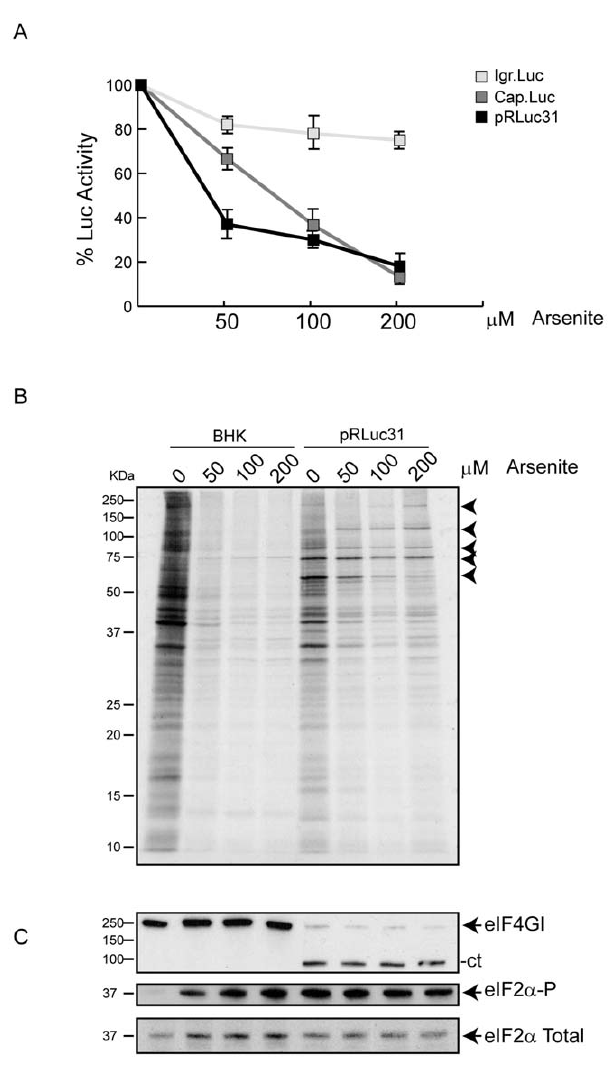
Figure 1. Effect of eIF2 phosphorylation induced by Ars on PV protein synthesis. A) Cap-luc, PV replicon-luc or CrPV IGR-luc mRNAs synthesized in vitro by T7 RNA polymerase were electroporated in BHK- 21 cells and seeded in DMEM (10% FCS). Different amounts of Ars (0, 50, 100 and 200 m M) were added and cells were incubated for 60 min before harvesting to analyze luc. Error bars indicate standard deviations (SD) obtained from three measurements of each sample. B) BHK-21 cells were electroporated with RNA of PV replicon. At 7 hpe cells were treated with different concentrations of Ars and labelled with [ 35 S]Met/ Cys for 45 minutes. Samples were analyzed by SDS-PAGE (17.5%) followed by fluorography and autoradiography. Arrows indicate viral proteins. C) eIF4GI, eIF2 a and phosphorylated eIF2 a were detected by western blot.